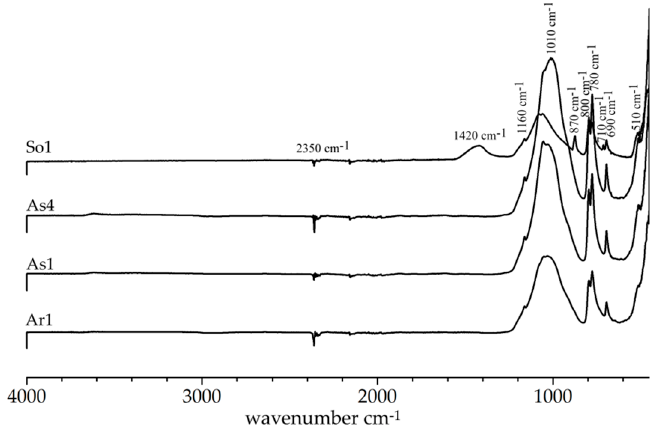
Figure 8. Infrared spectra of some chert samples from inland outcrops. The Raman spectrum of S2 chert is shown in Figure 9. The Raman spectrum section selected between 420 and 520 cm − 1 with baseline subtracted for spectrometric analysis is shown in the inset. The more intense band at 462 cm − 1 is associated with the presence of quartz [26,27], and the band visible around 500 cm − 1 is associated with the presence of four-member rings in the moganite structure and it is the analytical band [27,28]. Figure 9. Raman spectrum of S2 sample. In the inset, the spectrum between 420 and 520 cm − 1 show- ing the band corresponding to moganite (500 cm − 1 ) and quartz (462 cm − 1 ). In SAED micrographs of S2 sample particles (Figure 10) interplanar distances of 1.28, 1.45, 1.79, 2.44, 3.37 and 4.30 Å can be attributed to moganite [29], since they coincide with the d hkl (604), (600), (006), (020), (202) and (200), respectively.